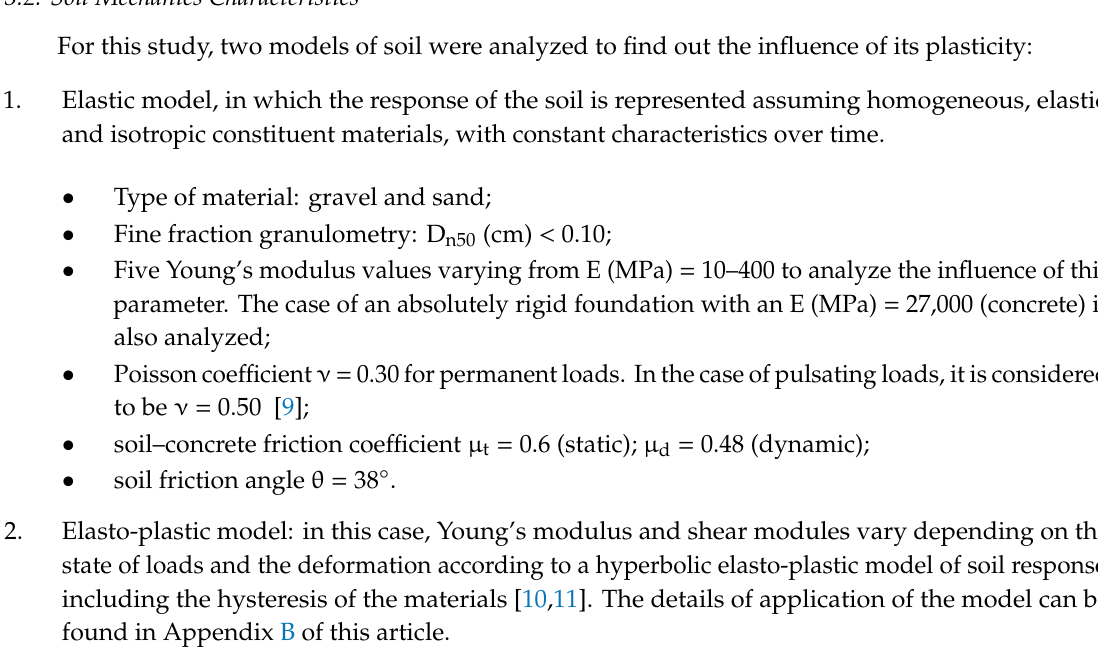
Figure 2. Cross section of the main breakwater of the outer port of Punta Langosteira (A Coruña, Spain).